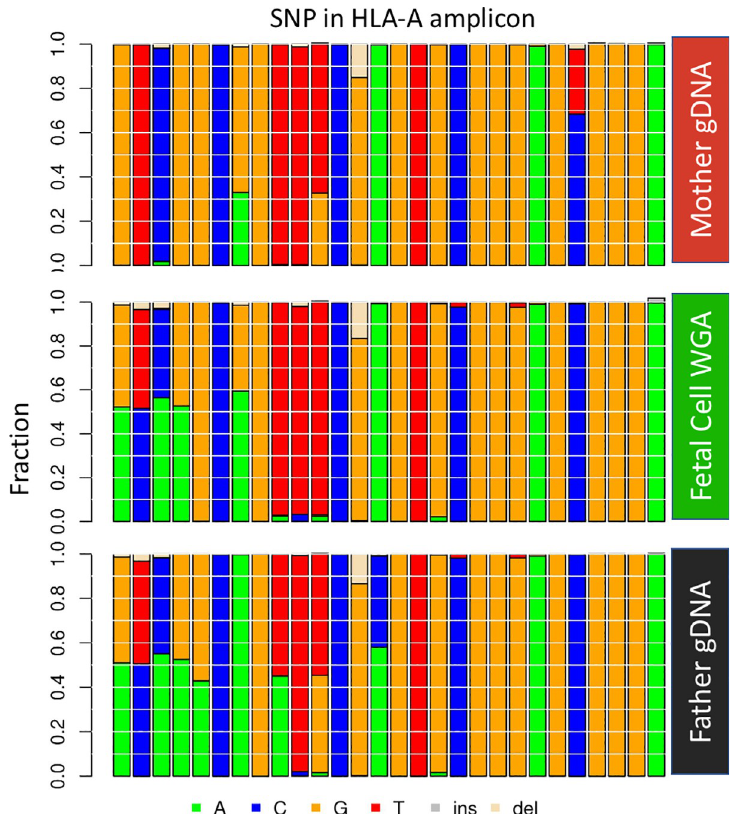
and indicate that the putative fetal cell is indeed fetal. The 24 SNPs to the right are not informative for the fetal cell as they do not have an allele that the mother does not have. Data from NIPT case number